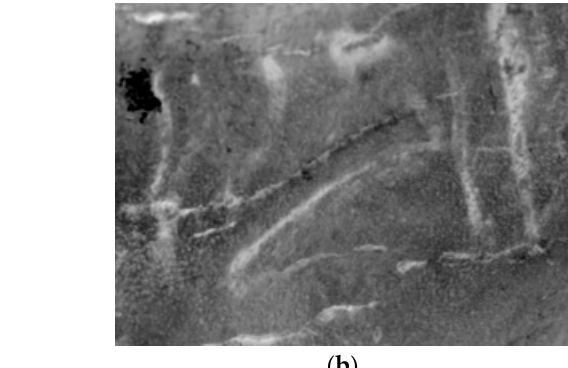
Figure 9. 2nd PCA component showing the recovery of figure contours as described in [3].